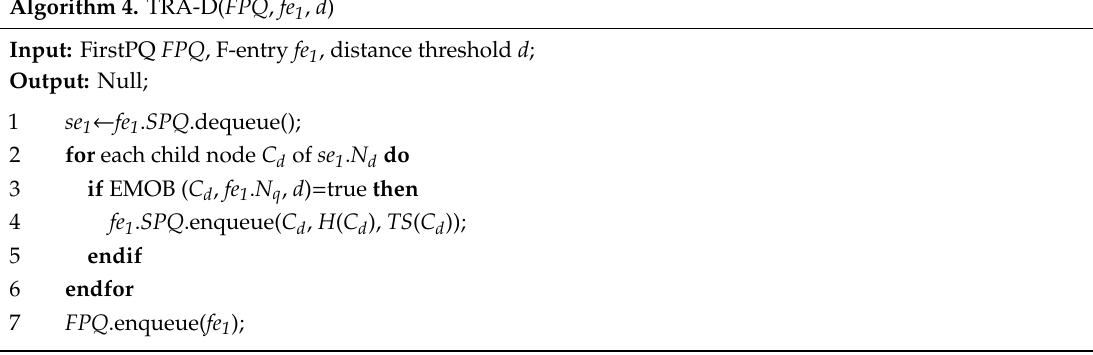
Algorithm 4. TRA-D( FPQ , fe 1 , d